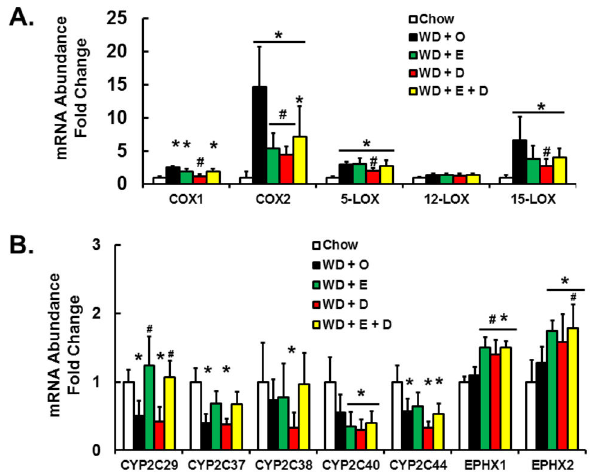
Figure 16. Expression of enzymes involved in fatty acid oxidation. Panel A: Hepatic expression of cyclooxygenases (COX1 & 2), lipoxygenases (5-. 12- & 15-LOX). Panel B: Hepatic expression of cytochrome P450-C2 (CYP2C subtypes) and soluble and microsomal epoxide hydroxylases (EPHX1 and 2). Results are represented as mRNA Abundance-Fold Change, mean ± SD; n=8/group; *, p ≤ 0.05 versus chow; #, p ≤ 0.05 versus WD + O.